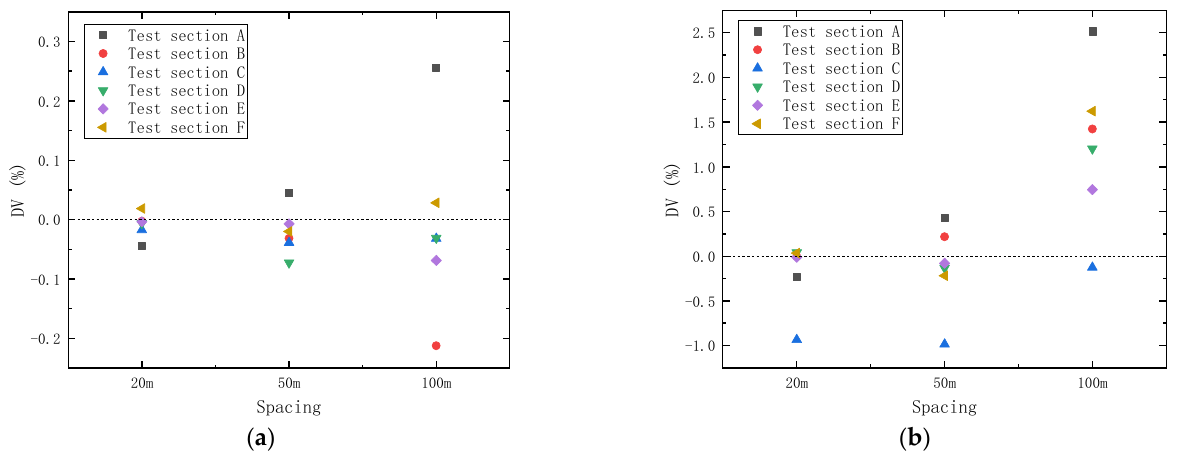
Figure 12. Variation of deviation value with the increasing detection spacing: ( a ) average value; ( b ) representative value.